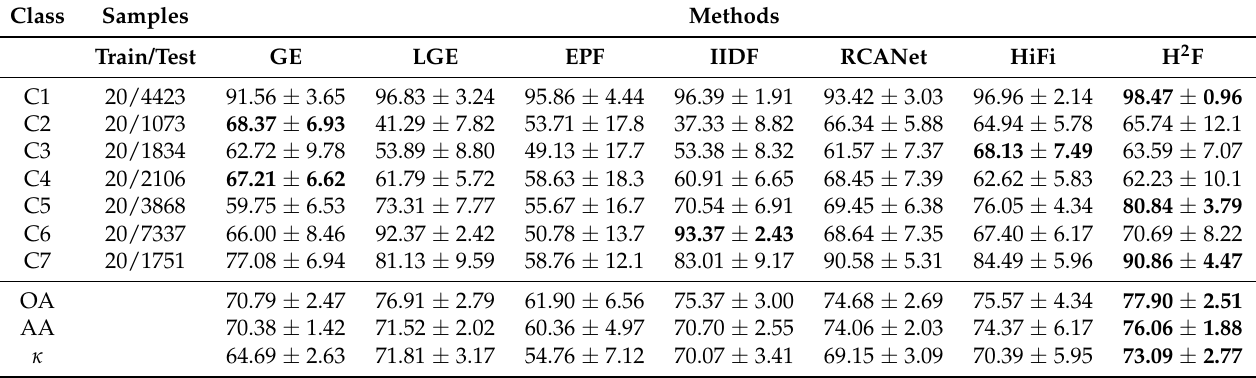
Table 3. Classification accuracies of different methods on the GRSS_DFC_2014 data set